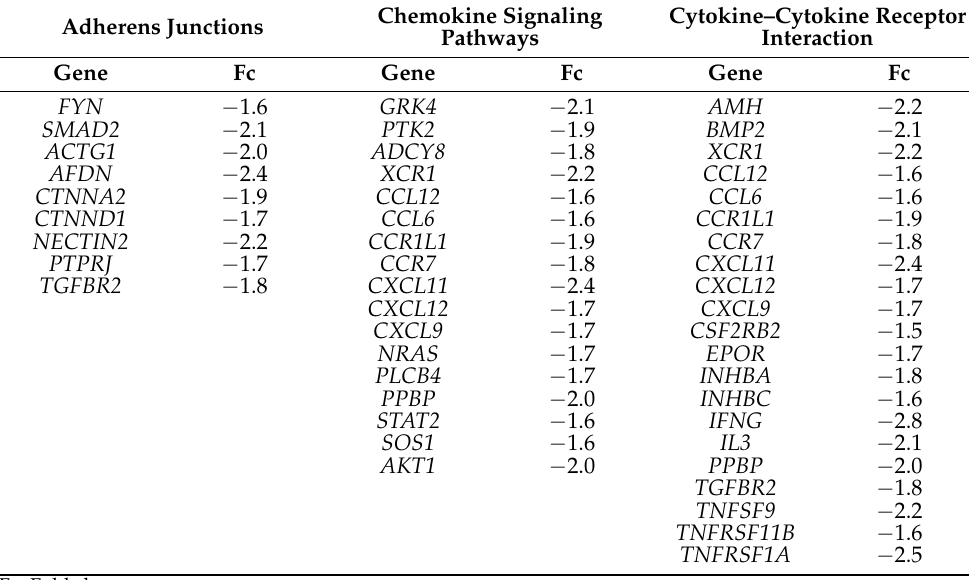
Table 7. Changes in the gene expression of dogs fed with the polyherbal vs. choline chloride in the inflammatory process and immune response.